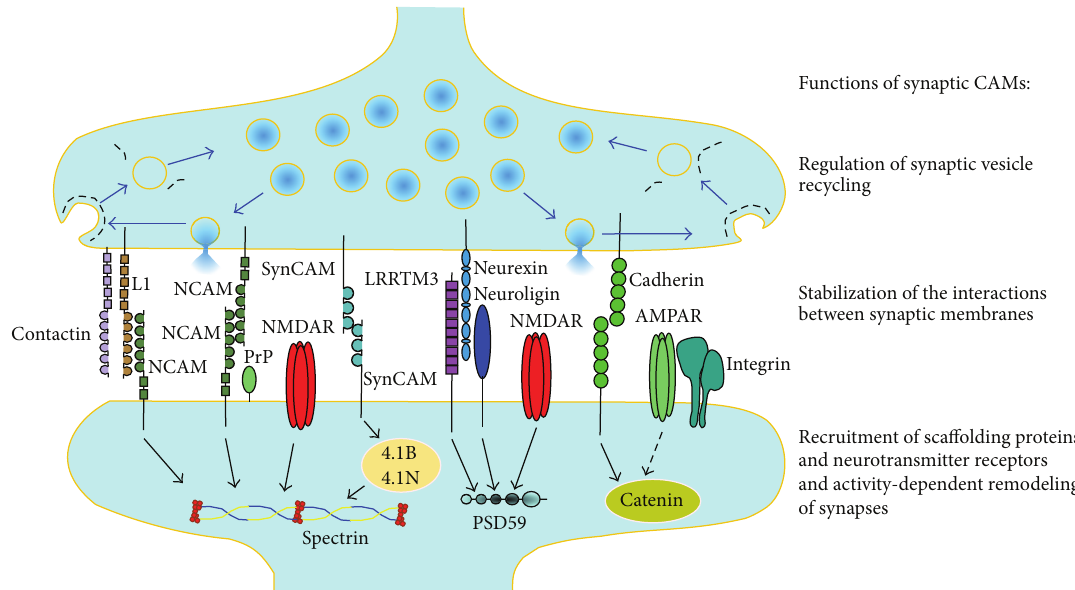
Figure 1: Schematic diagram illustrating examples of synaptic CAMs in glutamatergic synapses. Synaptic CAMs accumulate in synaptic membranes where they form homophilic (e.g., NCAM-NCAM, SynCAM-SynCAM, and cadherin-cadherin) or heterophilic (e.g., L1-NCAM, neuroligin-neurexin, and LRRTM3-neurexin) adhesion bonds, which are important for stabilization of the interactions between synaptic membranes. Presynaptically, CAMs are involved in regulation of synaptic vesicle recycling (blue arrows), which is mediated by coat proteins (black dashed lines) assembled on synaptic membranes to reform synaptic vesicles after exocytosis and neurotransmitter release. Postsynaptically, intracellular domains of synaptic CAMs interact with scaffolding and adaptor proteins (examples of interactions are shown with black arrows), such as spectrin, postsynaptic density protein 95 (PSD95), proteins 4.1B and 4.1N, or catenin, which link synaptic CAMs to postsynapticglutamatereceptors,the 𝛼 -amino-3-hydroxy-5-methyl-4-isoxazolepropionicacidreceptors(AMPAR)andN-methyl-D-aspartic acid receptors (NMDAR). Interactions with synaptic CAMs promote the recruitment of scaffolding proteins and neurotransmitter receptors to synapses and are involved in the activity-dependent remodeling of synapses. NCAM: neural cell adhesion molecule, SynCAM: synaptic cell adhesion molecule, PrP: cellular prion protein, and LRRTM3: Leucine-rich-repeat- (LRR-) containing transmembrane protein